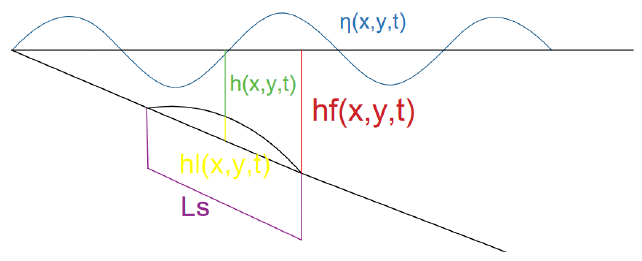
Figure 6. Sketch representing the main variables involved in the analytical model.